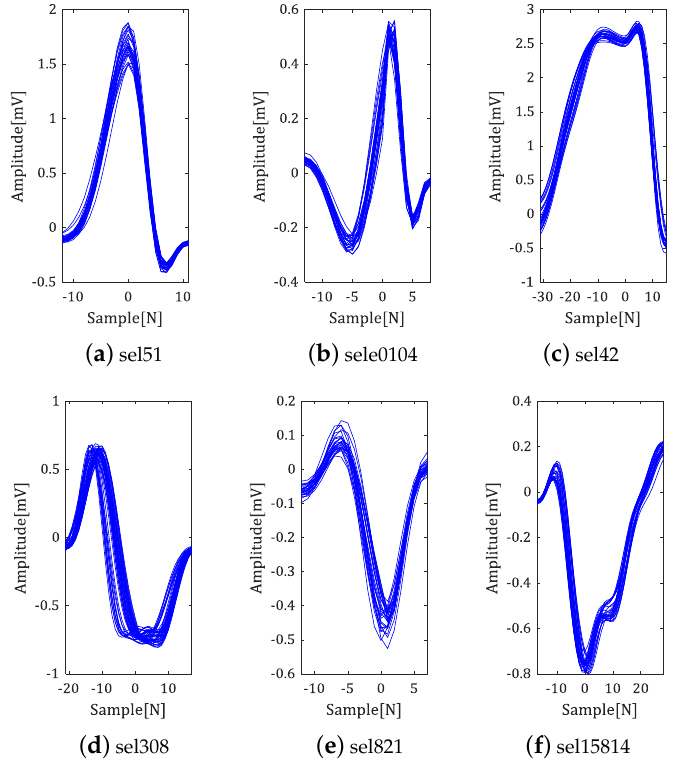
Figure 11. Clustering